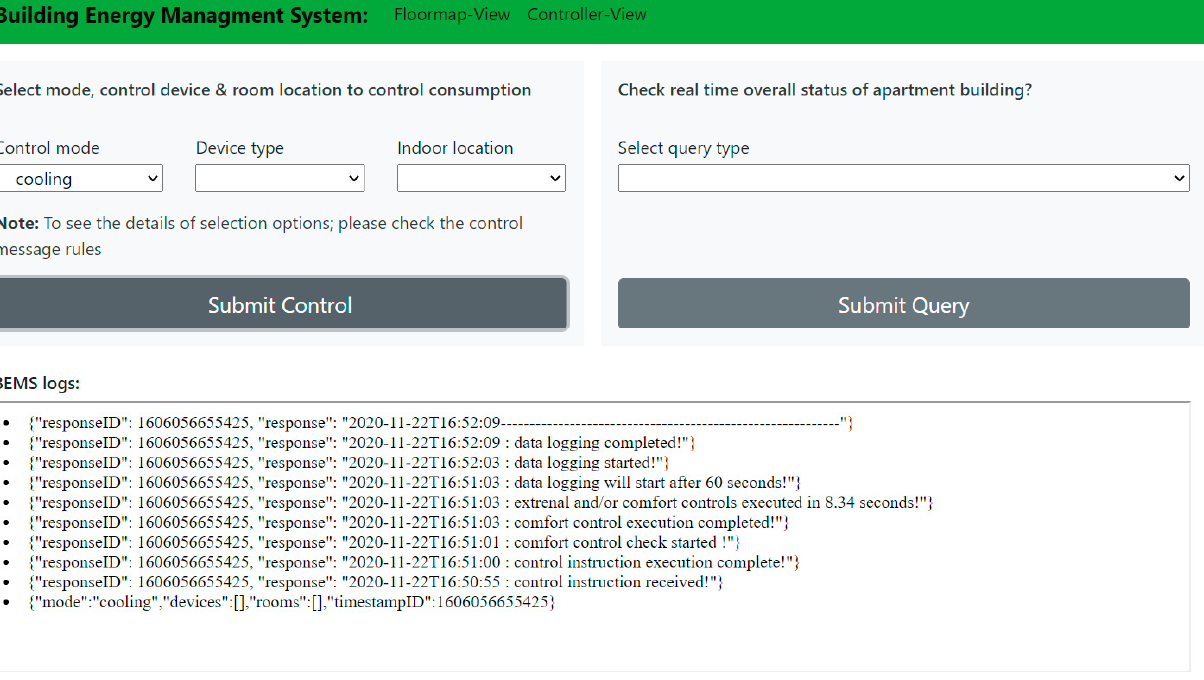
Figure 6. MQTT API-based control user interface for humans.